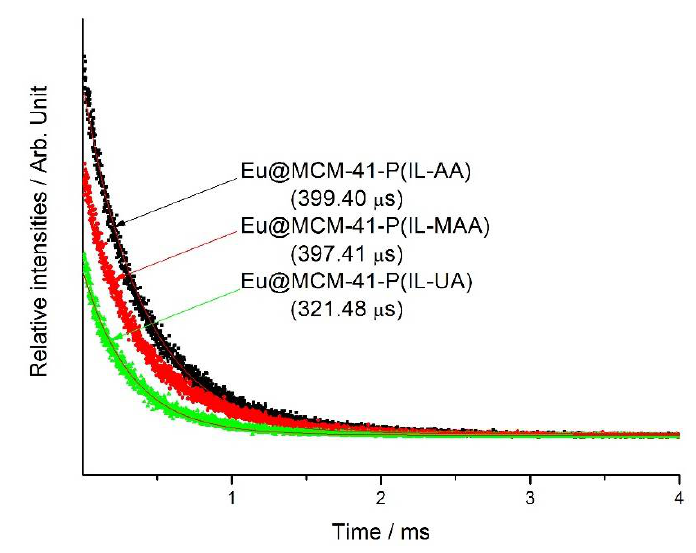
Figure 5. Luminescence decay curve for the 5 D 0 → 7 F 2 transition (612 nm) of the hybrid materials.